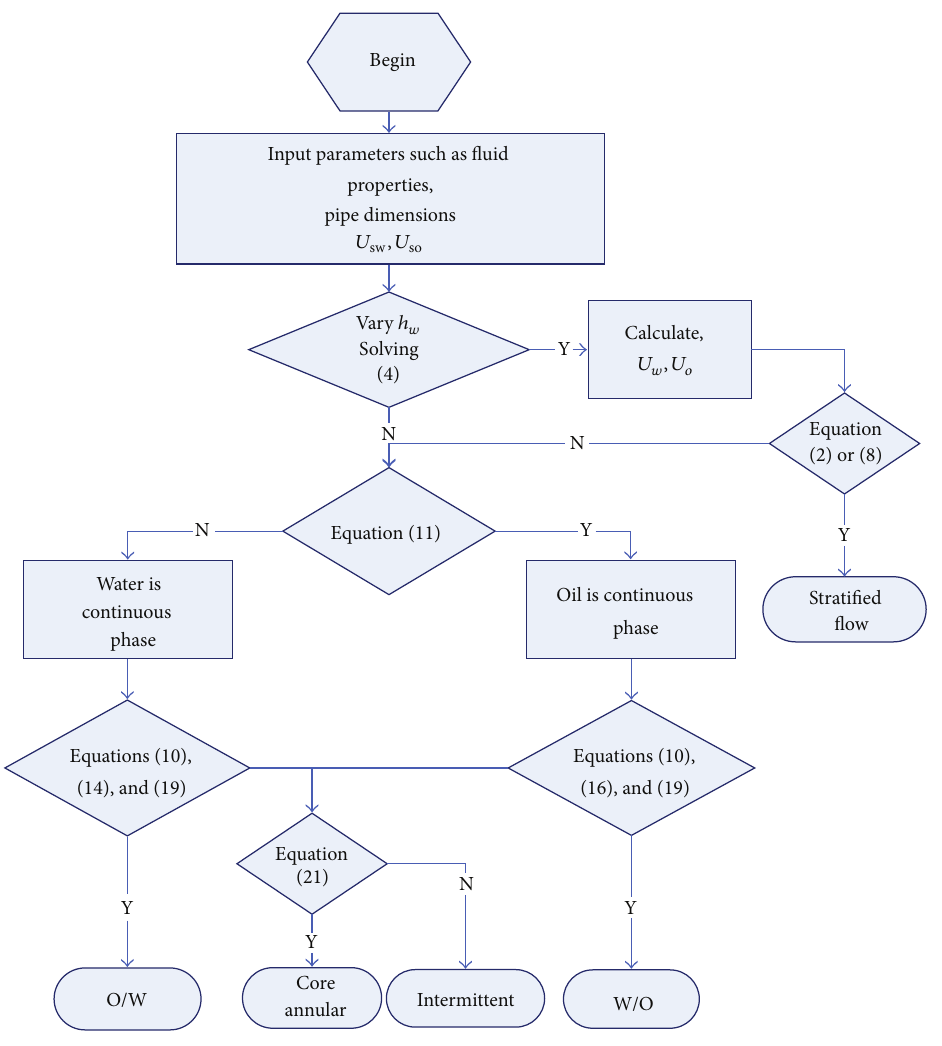
Figure 1: Diagram of flow pattern transition